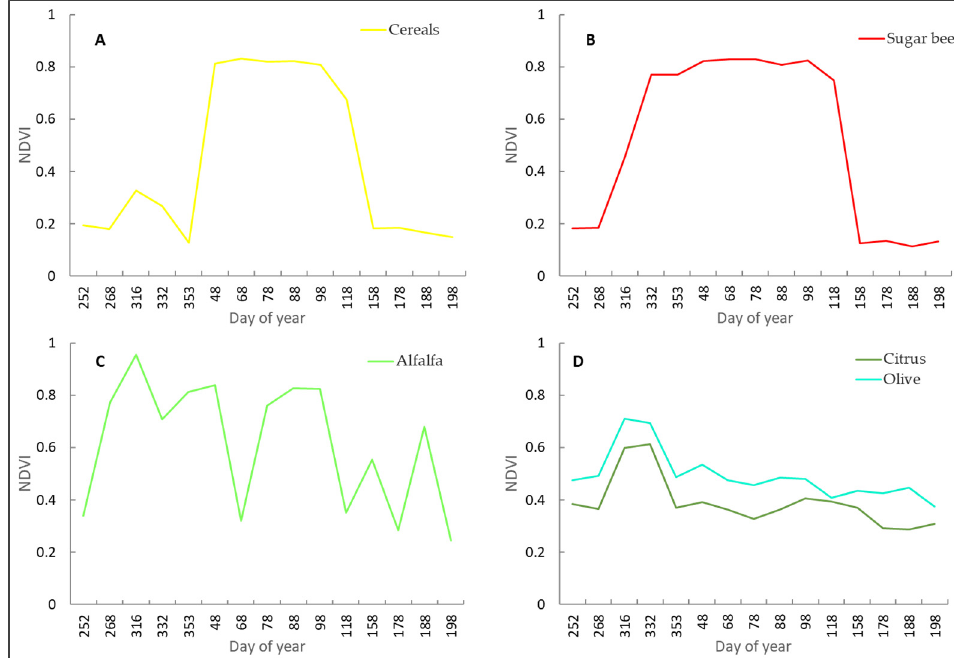
Figure 6. Spectral profiles of NDVI time series for the main crop types: ( A ) cereals; ( B ) sugar beets; ( C ) alfalfa; ( D ) citrus fruits and olives.